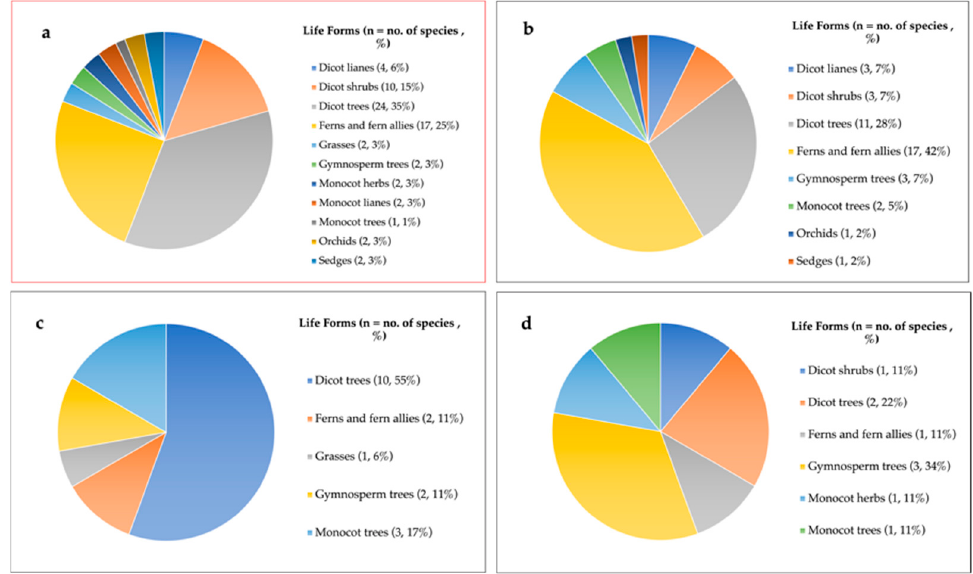
Figure 4. Life form analyses of Te Papanui (reference site; ( a )) and three kahikatea remnants, including Totara Park ( b ), Hillcrest Park ( c ) and Grove Park ( d ). The life forms considered in this analysis